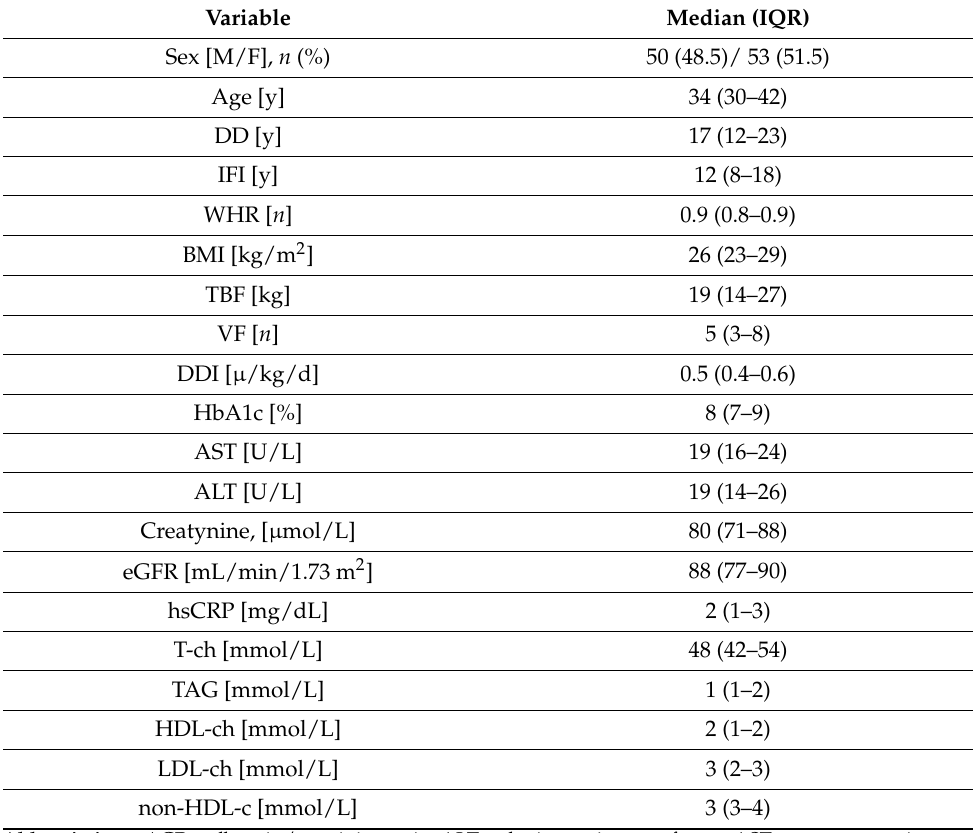
Table 1. Clinical characteristic of the study group ( n = 103). Data are presented as medians with interquartile